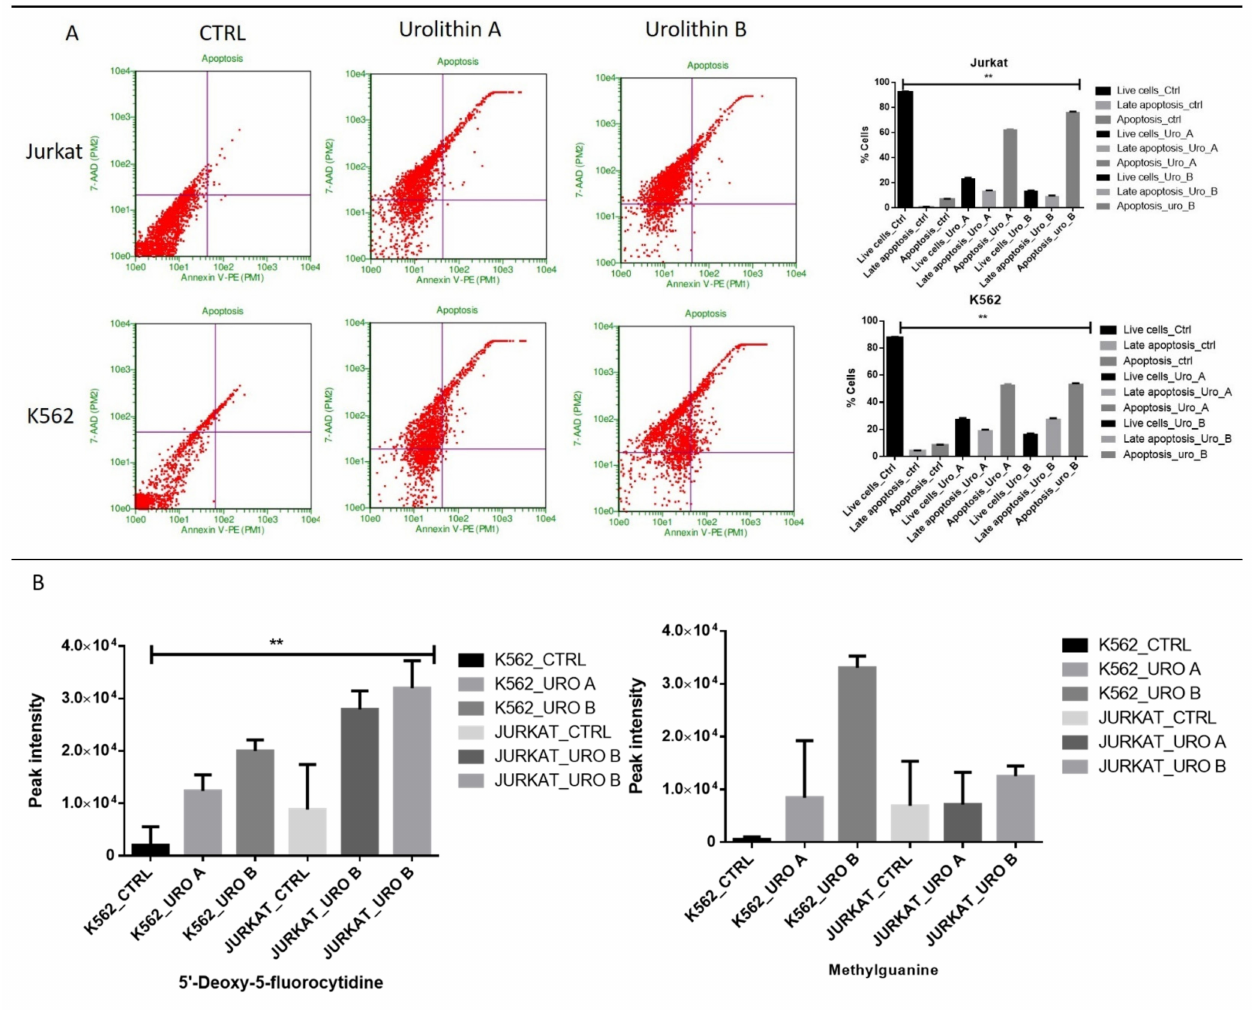
Figure 7. Urolithin A and B induce apoptosis in leukemic cells: ( A ) K562 and Jurkat cells were treated with urolithin A and B; apoptosis assay was performed by using Annexin V assay; ( B ) quantitative levels of various metabolites involved in DNA damage in urolithin A- and urolithin B-treated cells when compared with control, ** p <